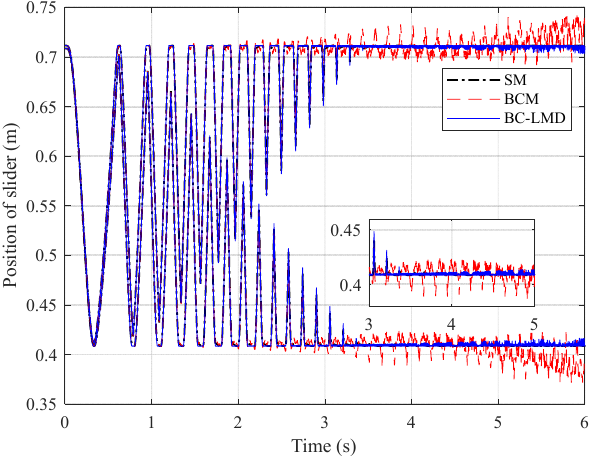
Figure 5. Bounds of the position of the slider.